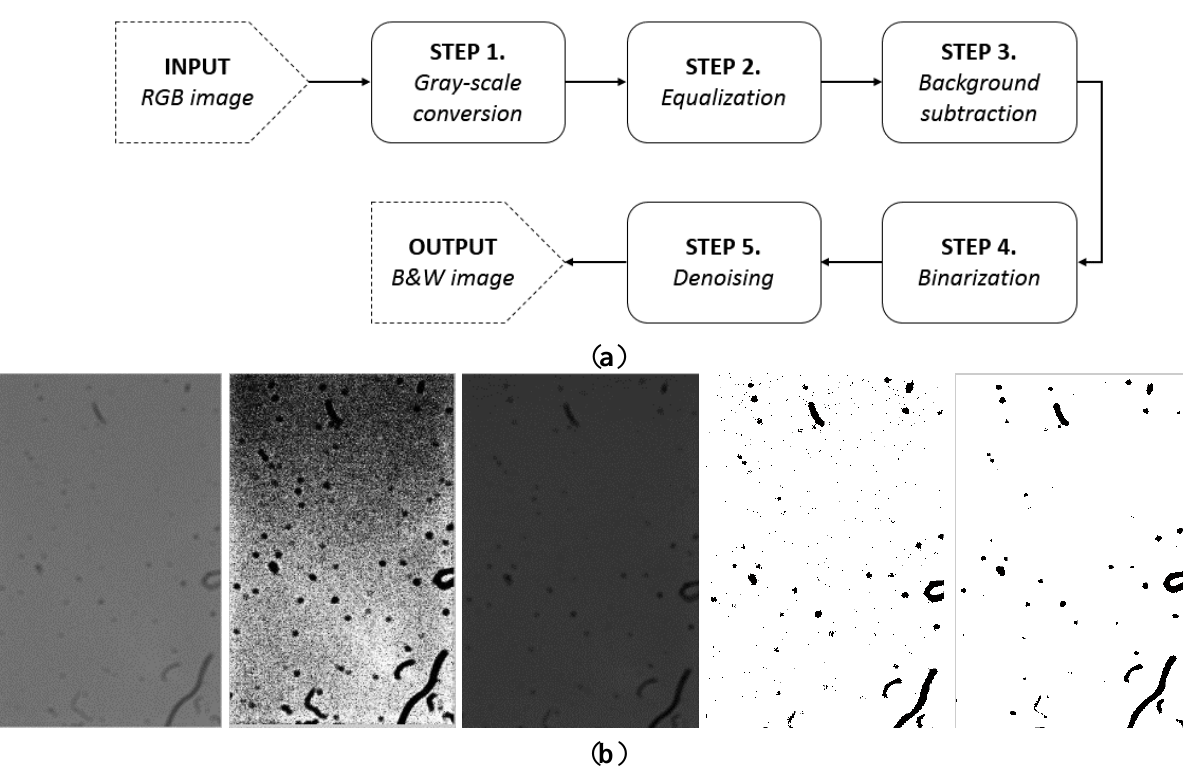
Figure 3. Preprocessing flowchart ( a ) and images resulting by each preprocessing steps ( b